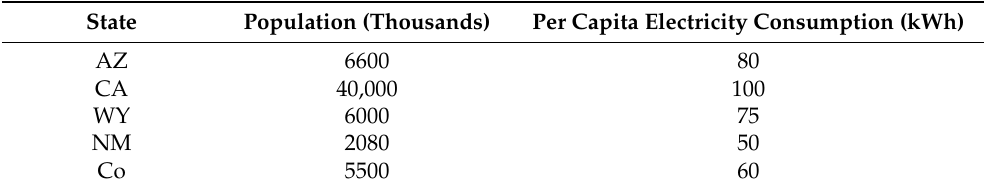
Table 1. The population and electricity consumption analysis in five states. Source: State Profile and Energy Estimates https://www.eia.gov/state/ (accessed on 20 January 2022). State Population (Thousands) Per Capita Electricity Consumption (kWh) AZ 6600 80 CA 40,000 100 WY 6000 75 NM 2080 50 Co 5500 60